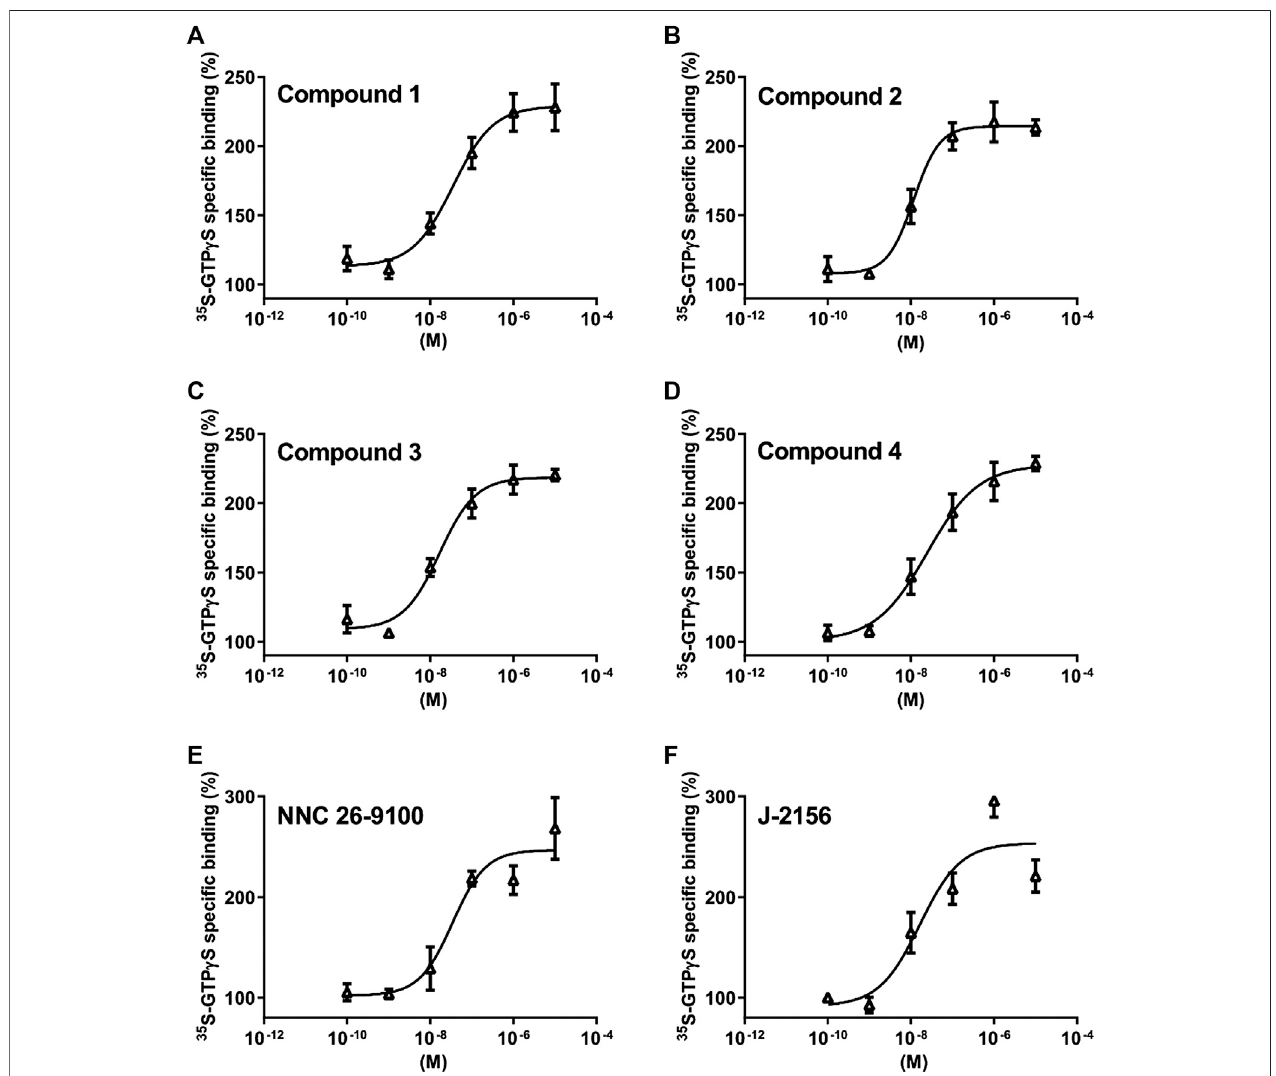
FIGURE 3 | Effect of Compounds 1 – 4 compared with reference molecules NNC 26-9100 and J-2156 on SST 4 receptor-linked G protein activation. [ 35 S]GTP γ S binding induced by the compound in SST 4 -expressing CHO cells. The ligand-stimulated [ 35 S]GTP γ S binding re fl ects the GDP – GTP exchange reaction on α subunits of G proteins by receptor agonists. Increasing concentrations of all compounds result in similar concentration-dependent stimulations of [ 35 S]GTP γ S binding. Each data point represents the mean ± SEM of n (cid:2) 3 independent experiments, each performed in triplicates.